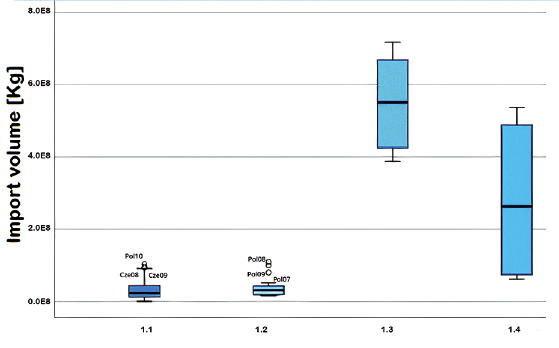
Figure 7. Box diagram of the pre-crisis import variable according to the clusters of the second two-stage clustering level (source: own elaboration)